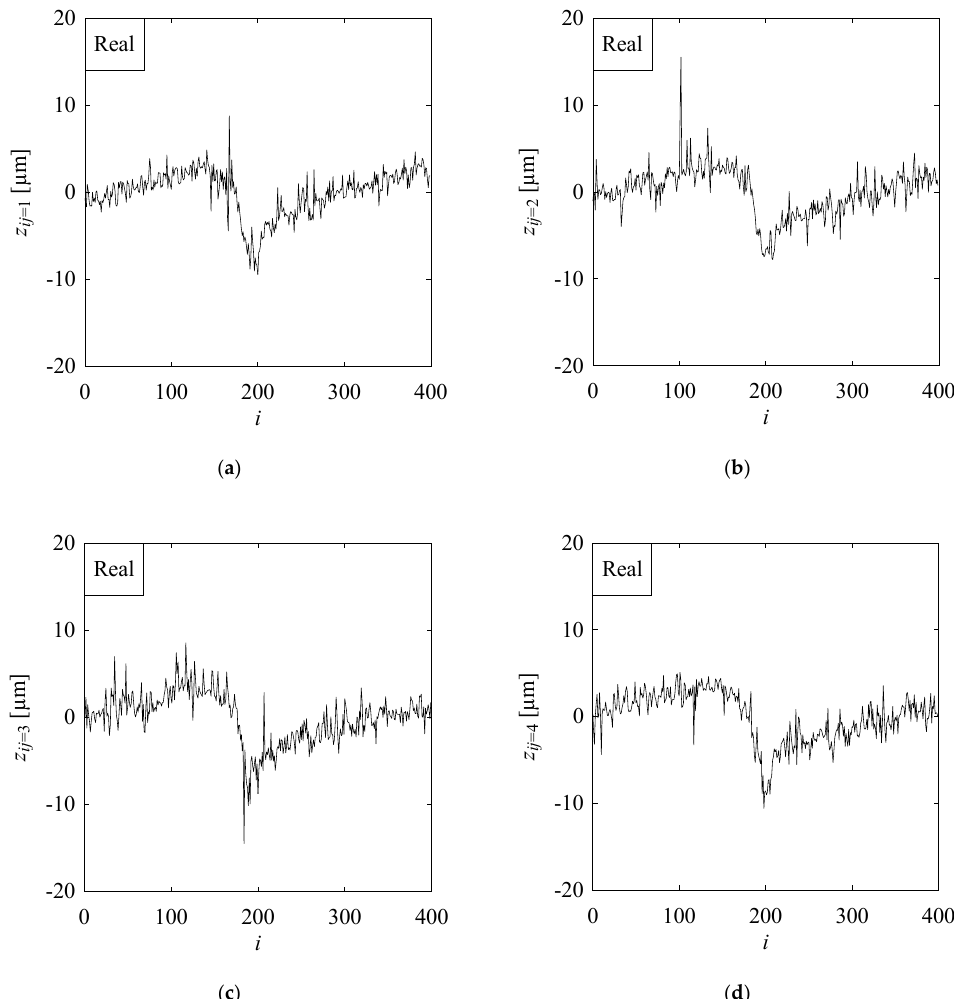
Figure A1. Measured surface heights [51]: ( a ) j = 1; ( b ) j = 2; ( c ) j = 3; ( d ) j = 4.